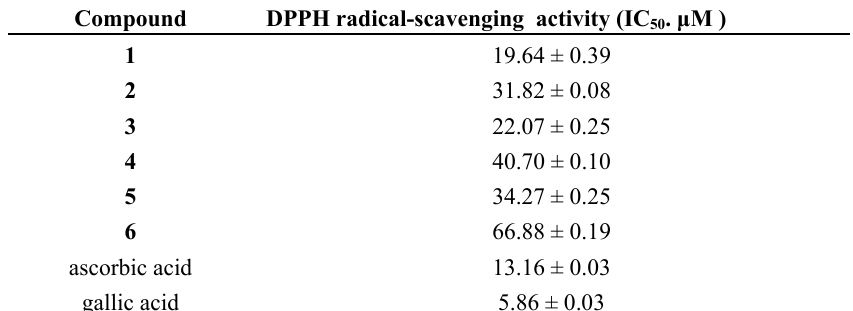
Table 4. In vitro DPPH radical scavenging activities of prenylated xanthones isolated from the bark of G.